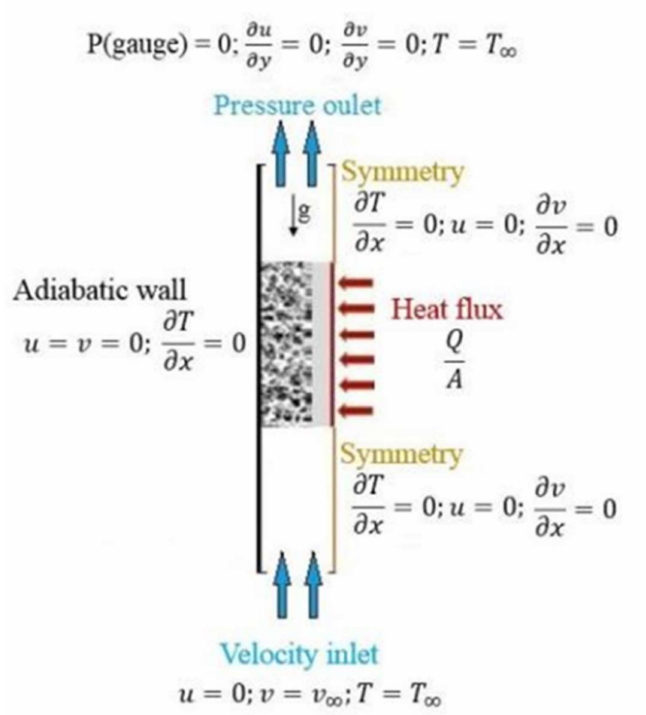
Figure 2. Sketch of complete thickness (100% foam filled) numerical domain with assigned boundary